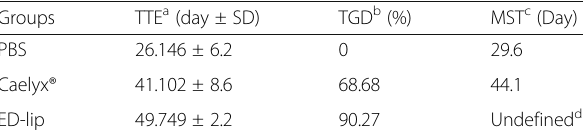
Table 4 Therapeutic efficacy data of Caelyx® and ED-lip in mice bearing C26 tumor